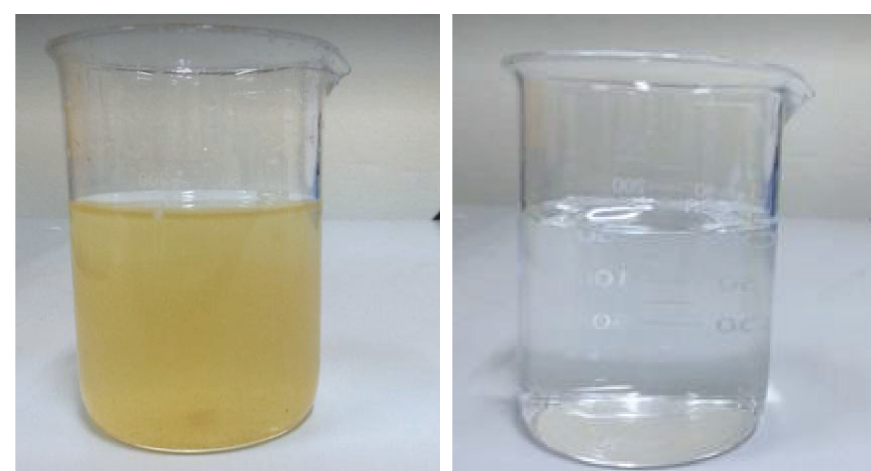
Figure 8: Groundwater sample before and after